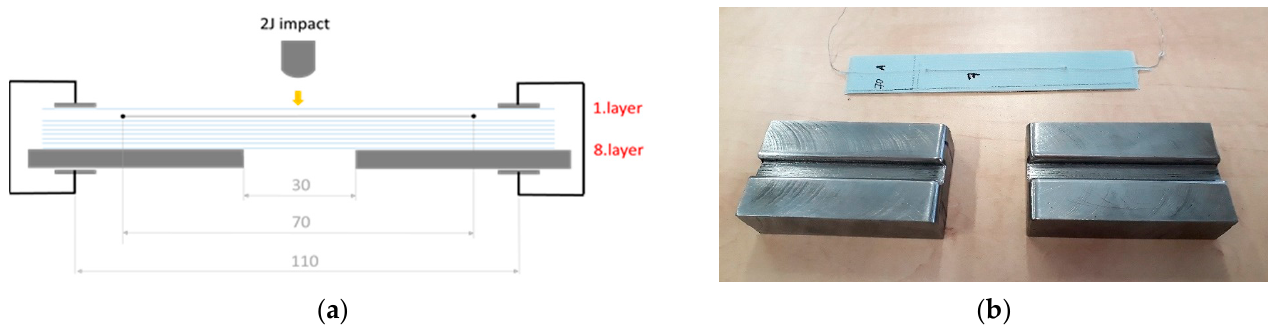
Figure 3. Configuration of the drop weight impact test: ( a ) schema of the impact test; ( b ) supports for the impact test.